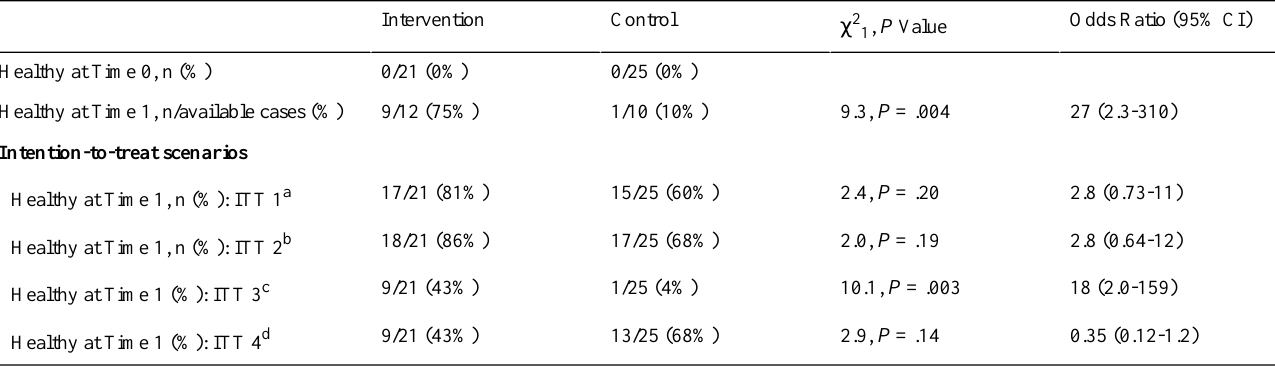
Table 4. Outcome measures: available cases and intention-to-treat (ITT) analysis